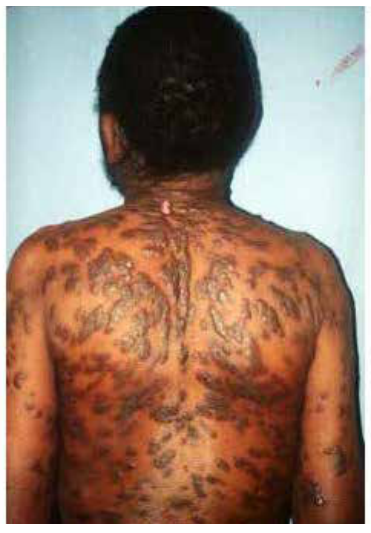
Figure 12. Multiple plaques of Kaposi sarcoma in HIV